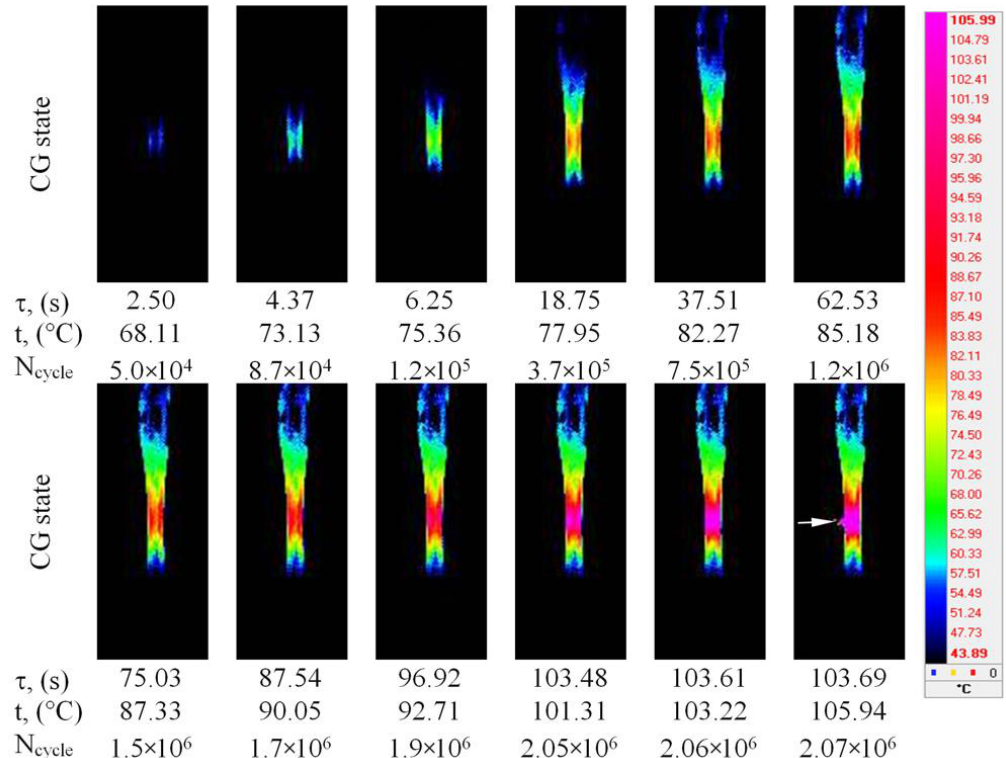
Figure 8. Thermal field images in the infrared zone, recorded during the cyclic loading of the CG Ti-45Nb sample: τ (s)—time, N—number of loading cycles, t—maximal temperature on the surface.